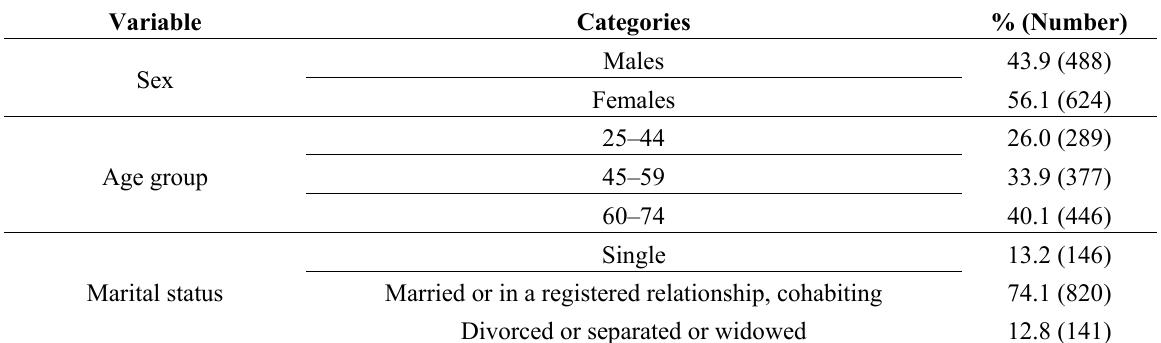
Table 1. Demographic data of